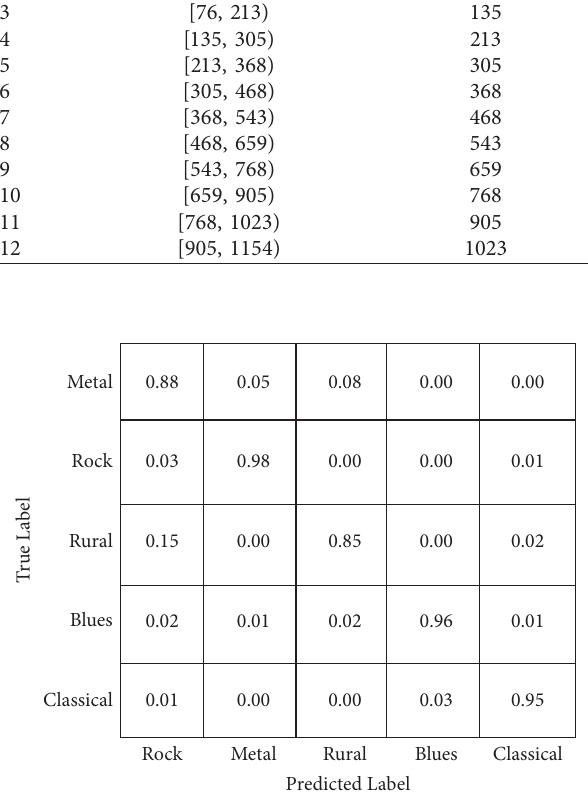
Figure 6: Automatic classification effect of music genre of the proposed